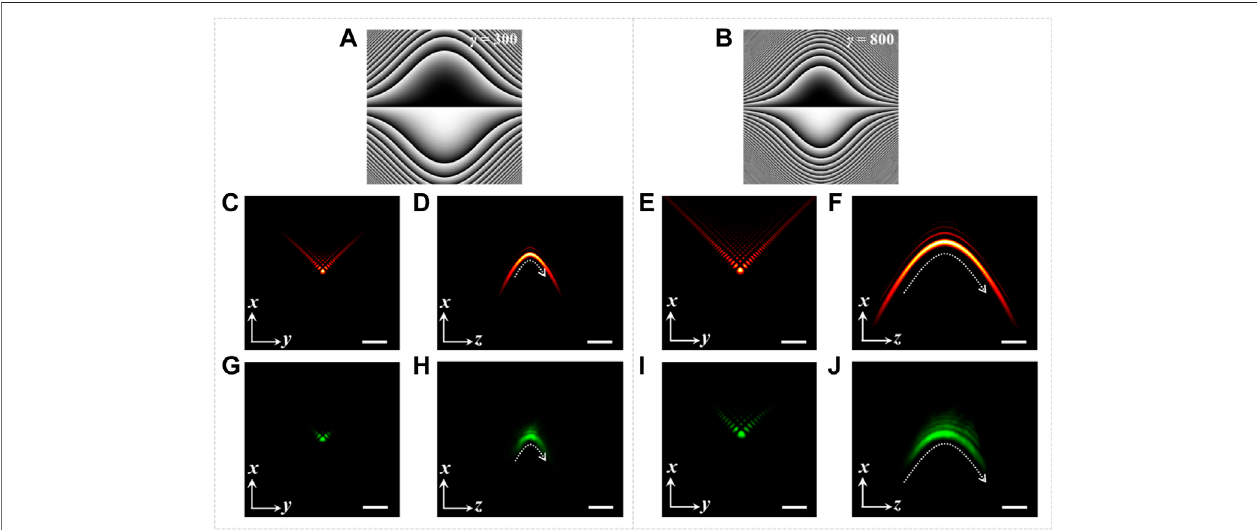
FIGURE 2 | Modulation of Weber beams. (A,B) Phase masks of Weber beams with γ (cid:1) 300 and 800, respectively; (C – F) simulated results of the lateral and axial cross-sections ofWeber beams, (C) and (D) correspondto γ (cid:1) 300 , (E) and (F) correspond to γ (cid:1) 800; (G – J) experimental results ofthe lateral and axial cross-sections of Weber beams corresponding to (C – F) , respectively. Scale bar: 2 µm.